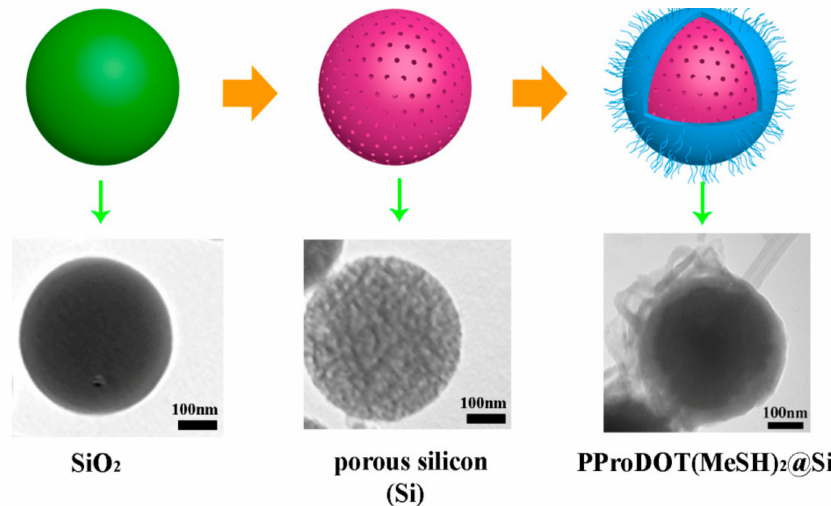
Figure 2. The synthesis route of PProDOT(MeSH) 2 @Si composite [56]. Reproduced with permission from Abdulla et al., Polymers (Basel) ; published by the MDPI, 2019.